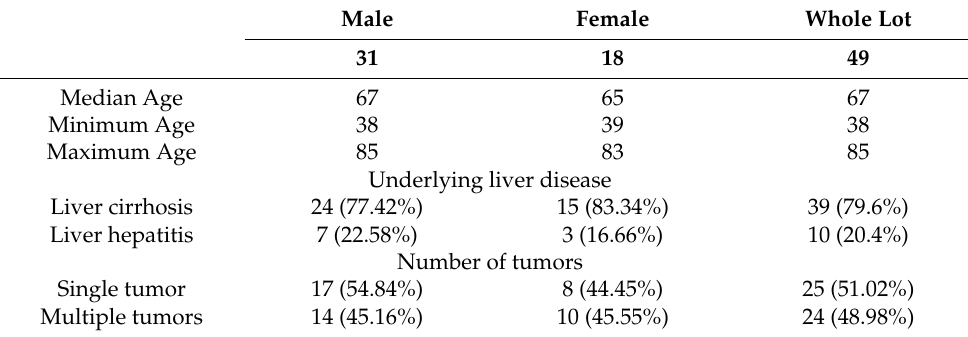
Table 1. Demographic information of the patients.